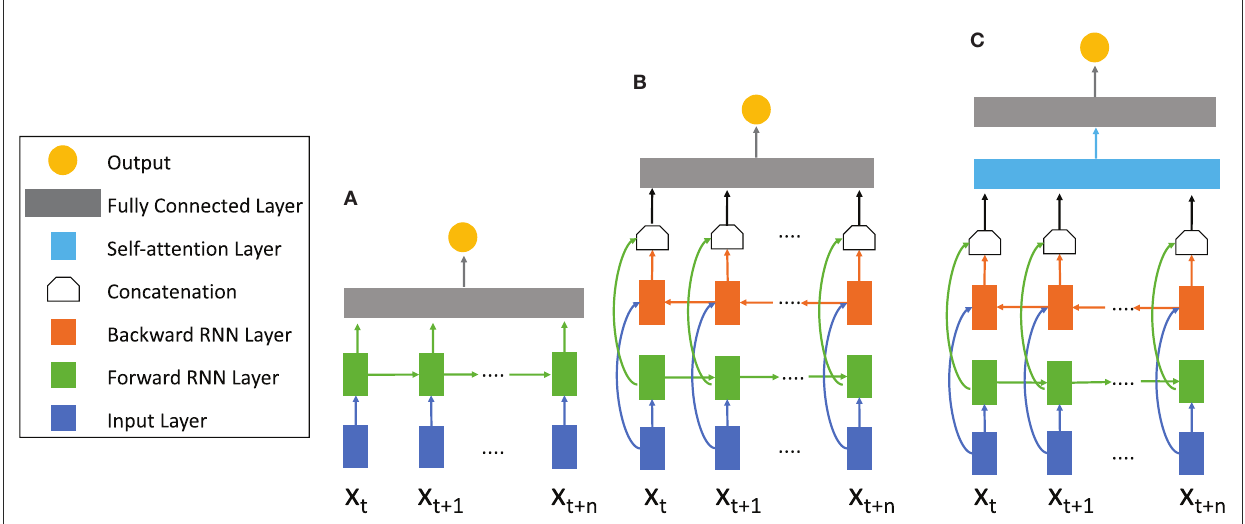
FIGURE5 RNN architectures with different mechanisms. (A) Basic RNN architecture consisting of the input layer (blue) the RNN forward layer (green), and a fully connected layer (gray). The sequence is only calculated forward in time. (B) Bidirectional RNN architecture. In addition to the forward RNN layer a backward RNN (orange) layer is added. Information from the future and the past is calculated simultaneously and concatenated, summed, multiplied or averaged afterwards. (C) Attention Bidirectional RNN architecture. After the forward and backward calculations have been concatenated, an attention layer (blue) is used to pay attention to important sections of the sequence. For different RNN topologies like LSTM and GRU the cells within the forward and backward layer differ (see Figure 4).